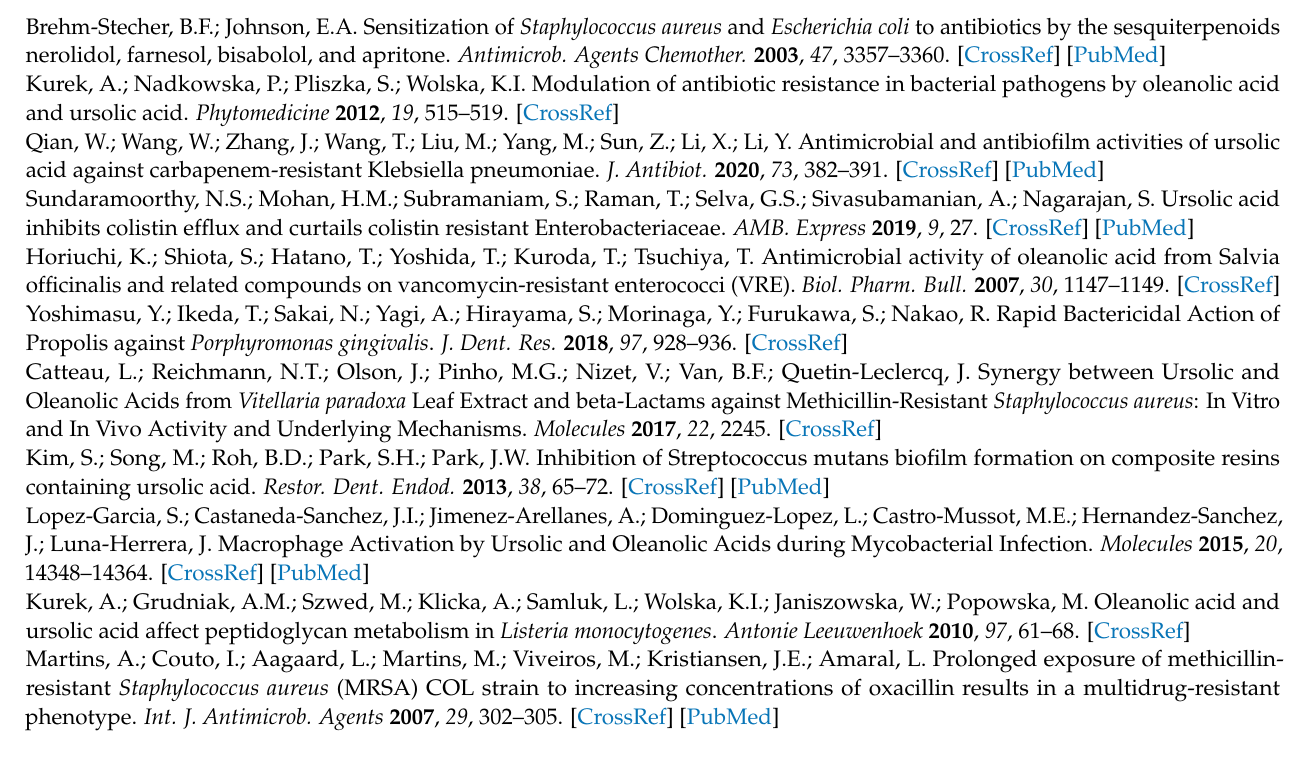
Figure S2: BODIPYTM-TR-cadaverine (BC) displacement from its binding to LTA induced by in- creasing concentrations of selected compounds UA (Ursolic acid) (vertical lines) or OA (Oleanolic acid)